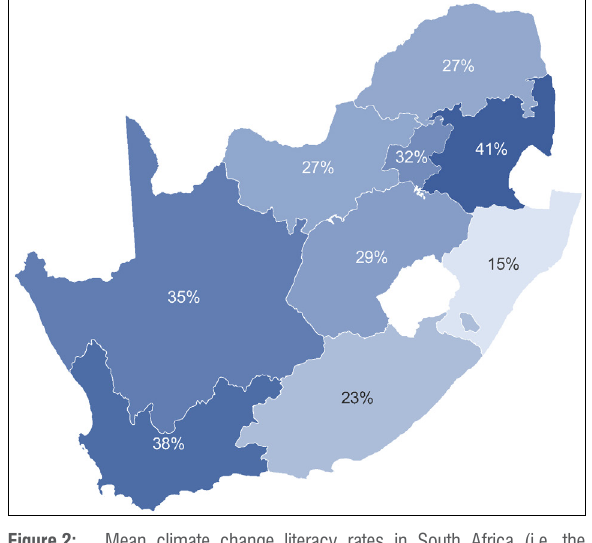
Figure 2: Mean climate change literacy rates in South Africa (i.e. the percentage of the population who have heard about climate change and think that human activity is its sole or partial